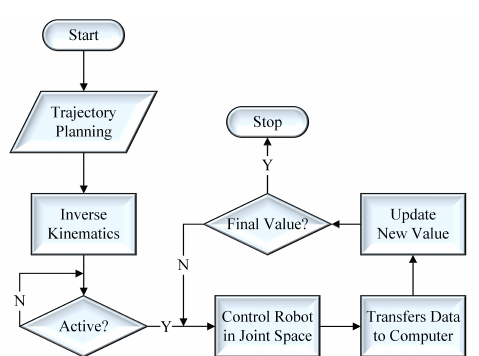
Fig. 5: Control (cid:29)owchart algorithm.